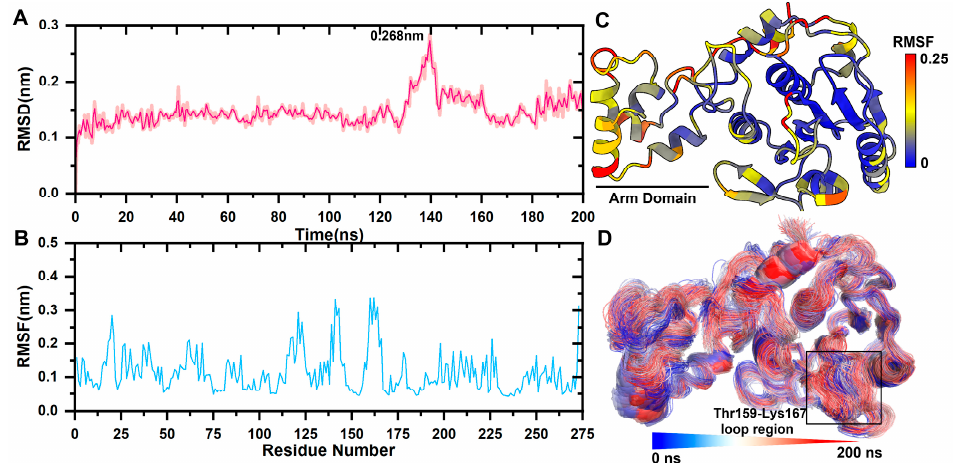
Figure 1. pS273R Molecular dynamics simulation. ( A ) Molecular kinetics of RMSD values for long-scaffolded carbon atoms of pS273R over 200 ns. ( B ) Molecular kinetics of RMSF values for amino acids of pS273R over 200 ns. ( C ) RMSF at 200 ns projected onto the pS273R structure. ( D ) Molecular dynamics simulation trajectory of pS273R from 0 to 200 ns. Note: Black box means the loop region of Thr159 ‐ Lys167 of pS273R.